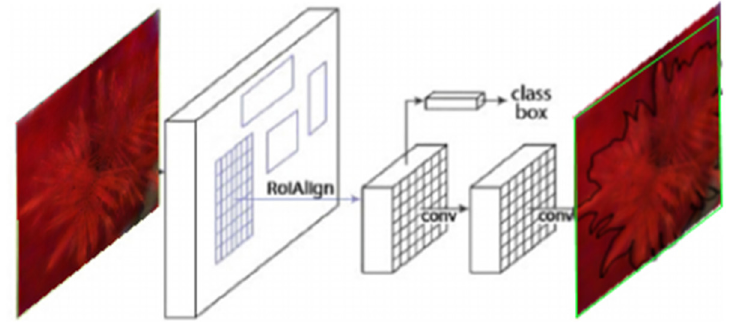
Figure 6. The framework of Mask RCNN, which shows that the classification and localisation did not depend on the mask prediction.